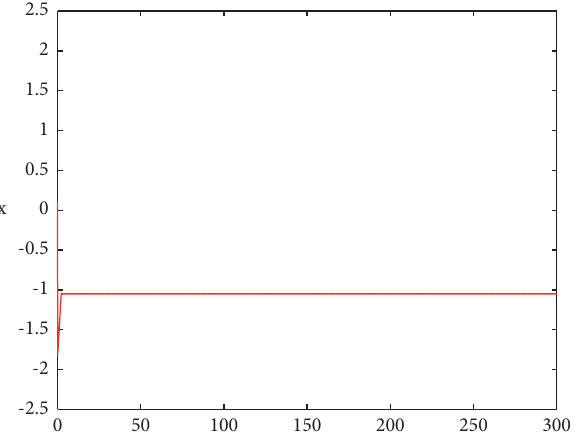
Figure 9: Temporal evolution of membrane potential x in FHN neuron system after the addition of flux-controlled memristor.